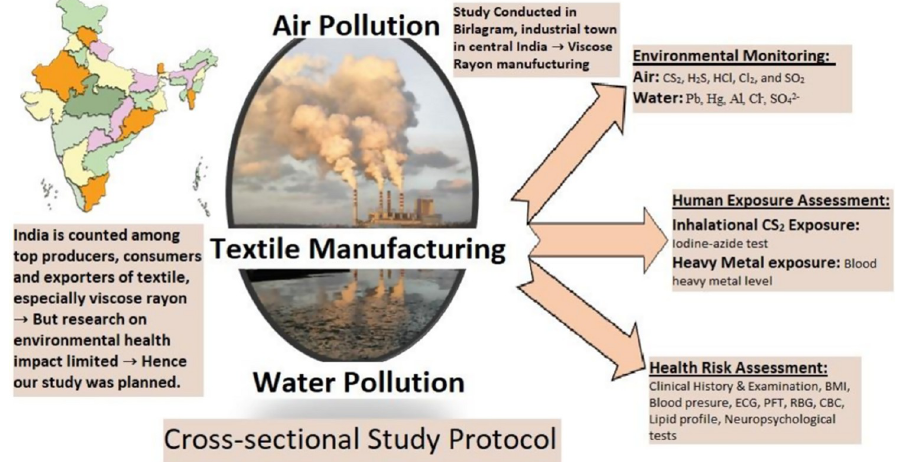
Fig 1. Graphical abstract: Overview of the study methodology. [Note: carbon disulphide (CS 2 ), Hydrogen sulphide (H 2 S), Hydrogen Chloride (HCl), Chlorine (Cl 2 ), Sulphur oxides (SO 2 ), lead (Pb), mercury(Hg), aluminium (Al), chloride (Cl - ), sulphate (SO 42- ), body mass index (BMI), Electrocardiogram (ECG), Pulmonary function test (PFT), Random Blood glucose (RBG), Complete blood count (CBC)] (The graphical abstract image has been created by the research team using copyright-free images of Indian map and industry from https://pixabay.com).